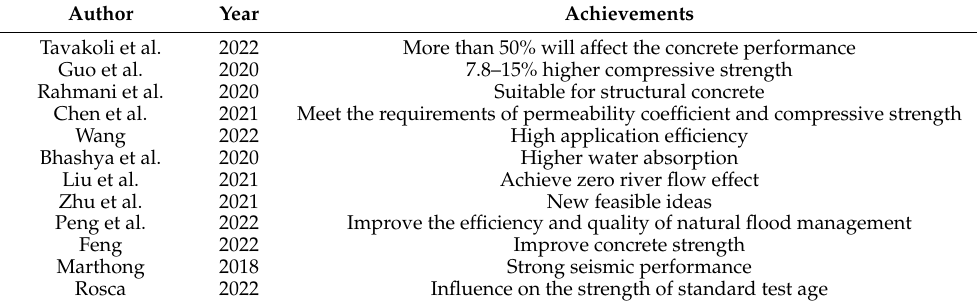
Table 1. Summary of current research